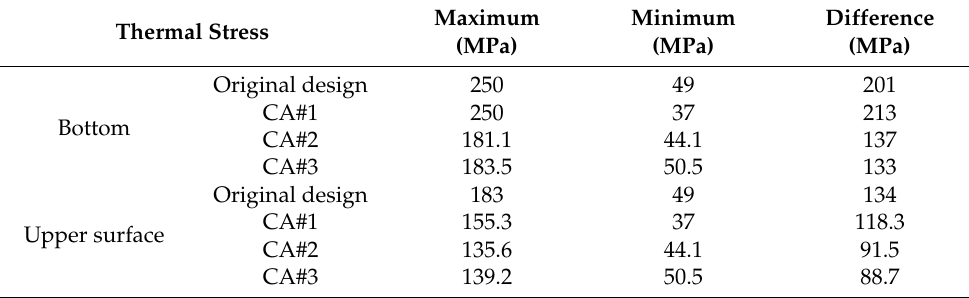
Table 5. Thermal stress differences of the original and improved stone grill plate